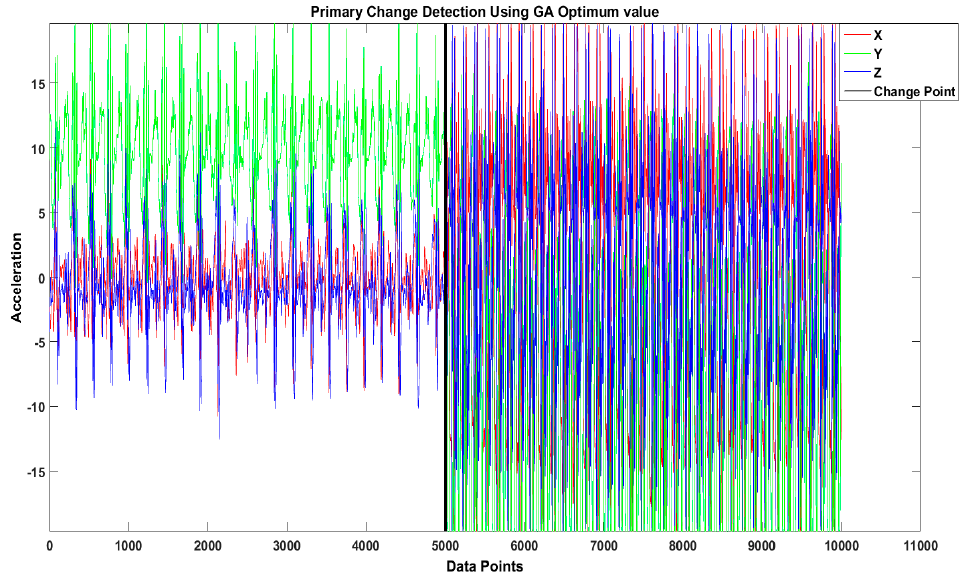
Figure 3. Real dataset example of sliding window change-detection result for the activity “walking to running”.